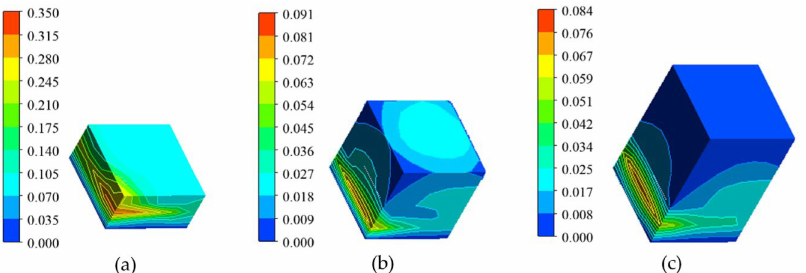
Figure 24. Cavitation volume distribution in texture dimples at different depths (( a ) is cavitaion contour when texture depth is 0.05 mm; ( b ) is cavitaion contour when texture depth is 0.1 mm; ( c ) is cavitaion contour when texture depth is 0.15